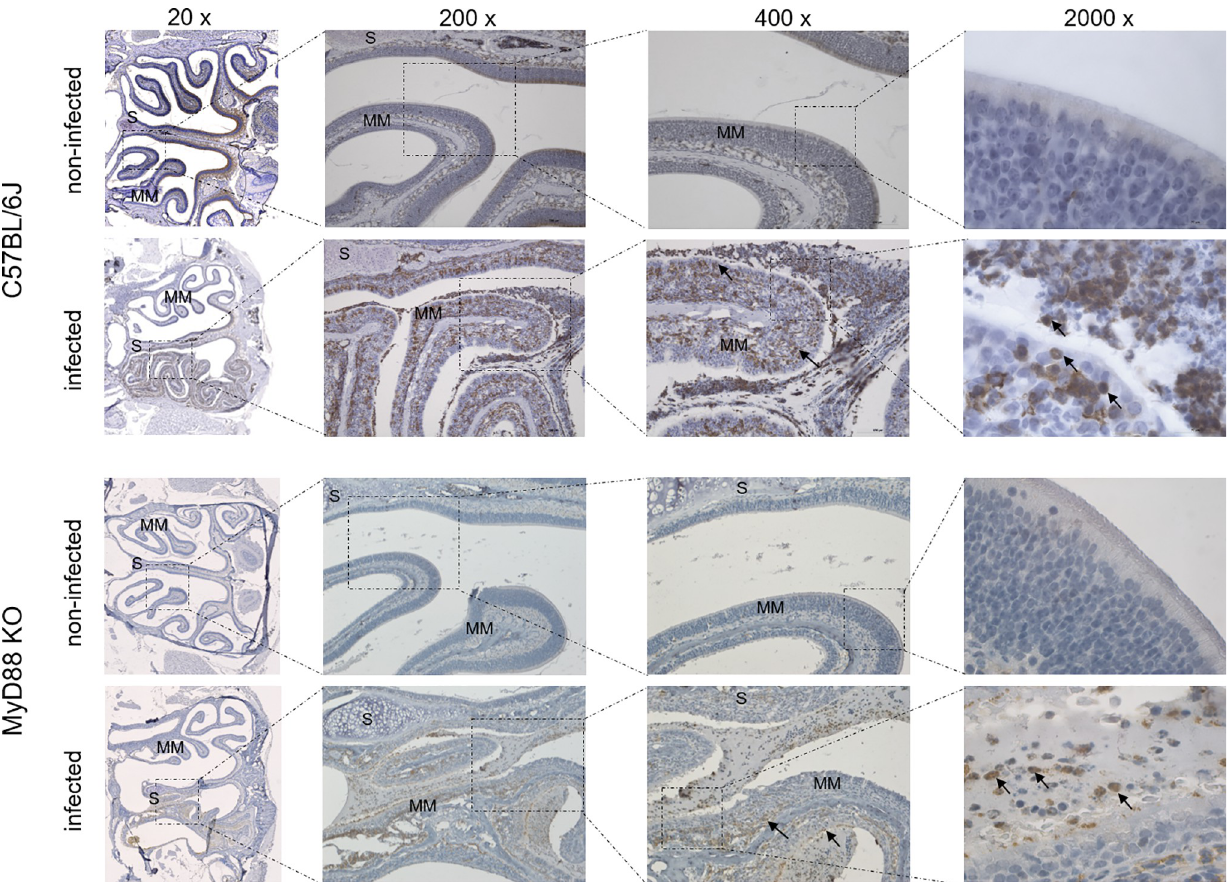
Fig 11. Macrophages are recruited into the B . pertussis -infected mouse nasal cavity. Immunohistochemical staining for the macrophage marker F4/80. Large numbers of macrophages (black arrows) are infiltrating the lamina propria and are detected in the mucopurulent exudate filling the cavities in infected mice. Representative images of stained level 2 coronal sections through the nasal cavity of MyD88 KO and C57BL/6J mice on day 7 after inoculation of nares with 5 μ l of suspension containing 10 7 or 10 9 CFU of B . pertussis bacteria, respectively. 3 mice per group were used and representative images of stained sections are